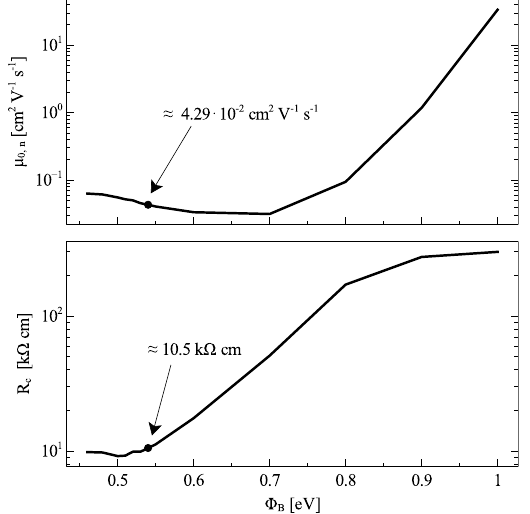
Figure 3. Low–field, low–density mobility μ 0, n (top) and contact resistance R C (at V g = + 35 V, bottom), for different values of the injection barrier Φ B . The dots on the curves identify the Φ B value that simultaneously yields in the best fitting of OTFT transfer characteristic curves and of MIS capacitor CF